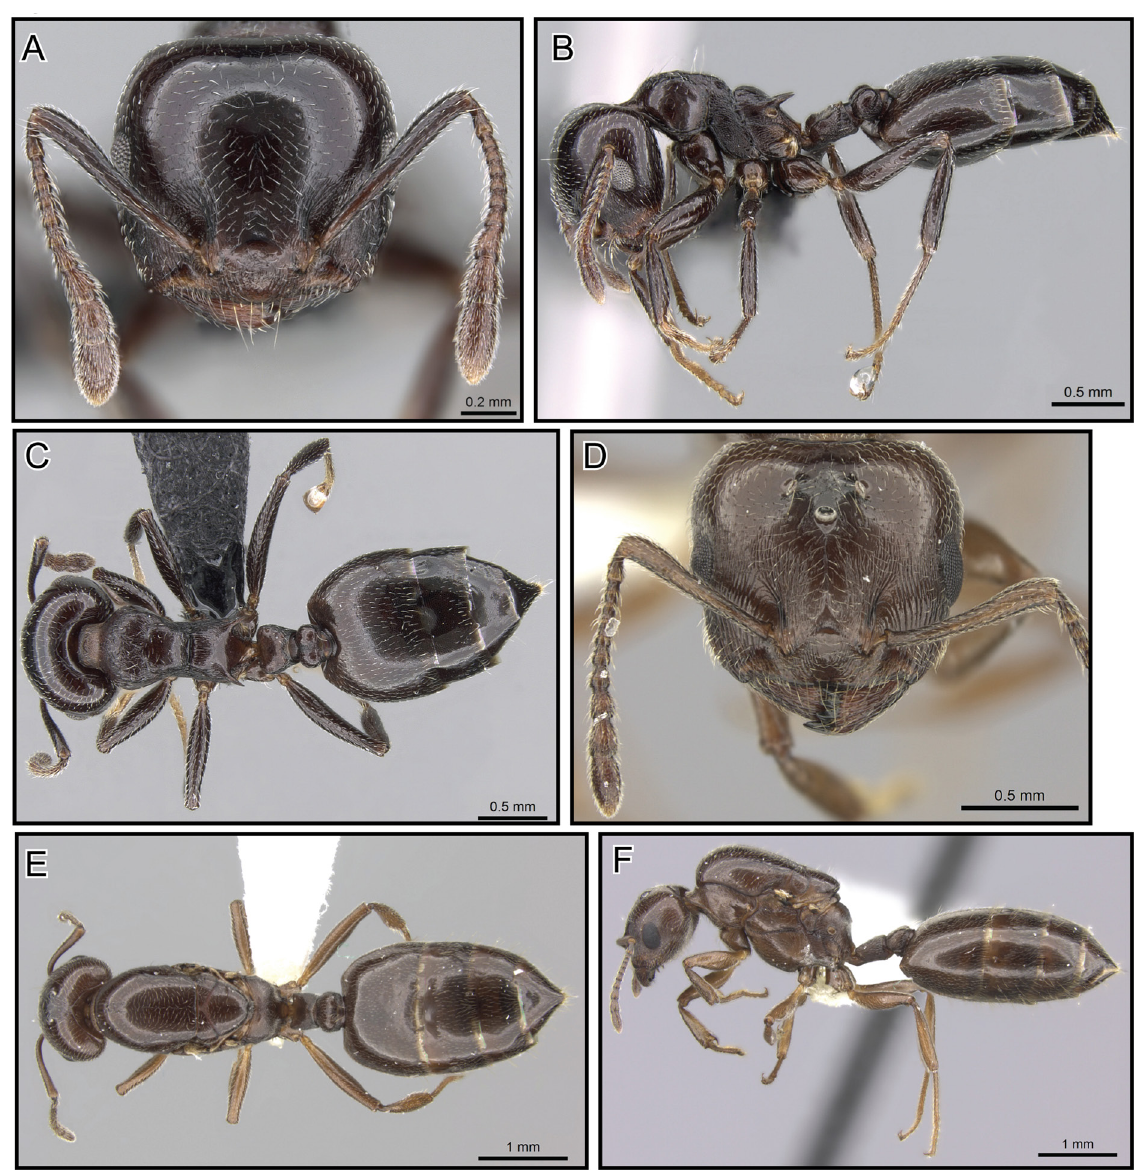
Fig. 8. Crematogaster degeeri Forel, 1886, worker and queen. A-C. Worker (CASENT0118982). A. Full-face. B. Profile. C. Dorsal. D-F. Queen (CASENT0012763). D. Full-face. E. Dorsal F.